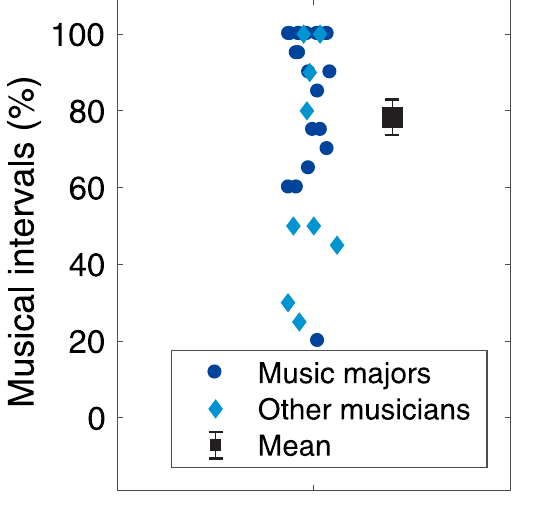
Figure 5. Proportion correct responses in the musical interval identification